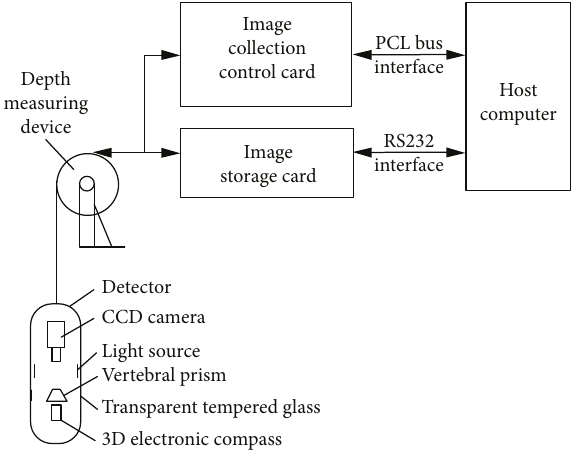
Figure 6: The schematic diagram of the drilling TV equipment ’ s working